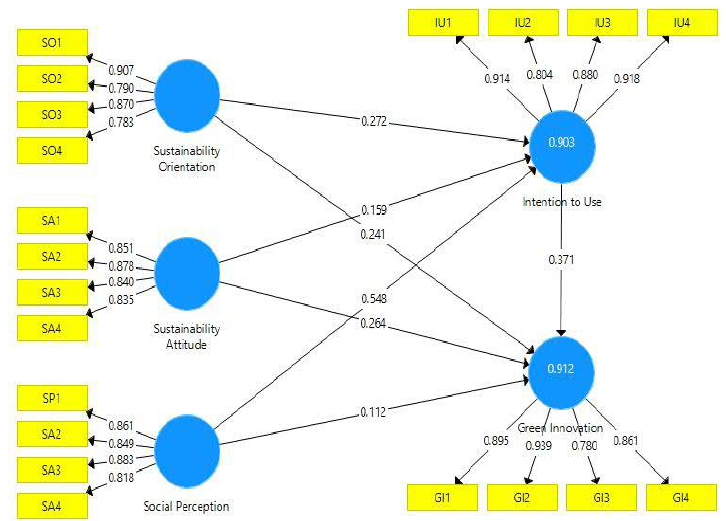
Figure 2. Standardized results of SEM calculations. Smart PLS 3.2.9 was used to produce the standardized SEM values shown in Figure 2.